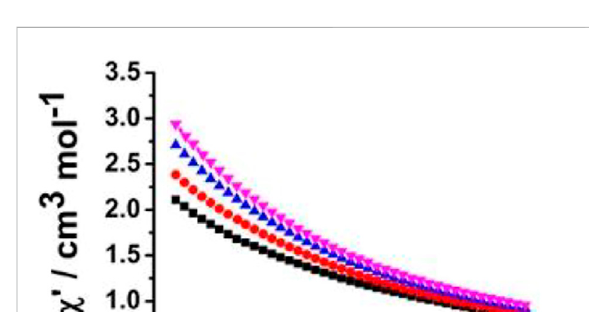
FIGURE 6 Magnetic fi eld-dependent magnetization plots of all prepared complexes.